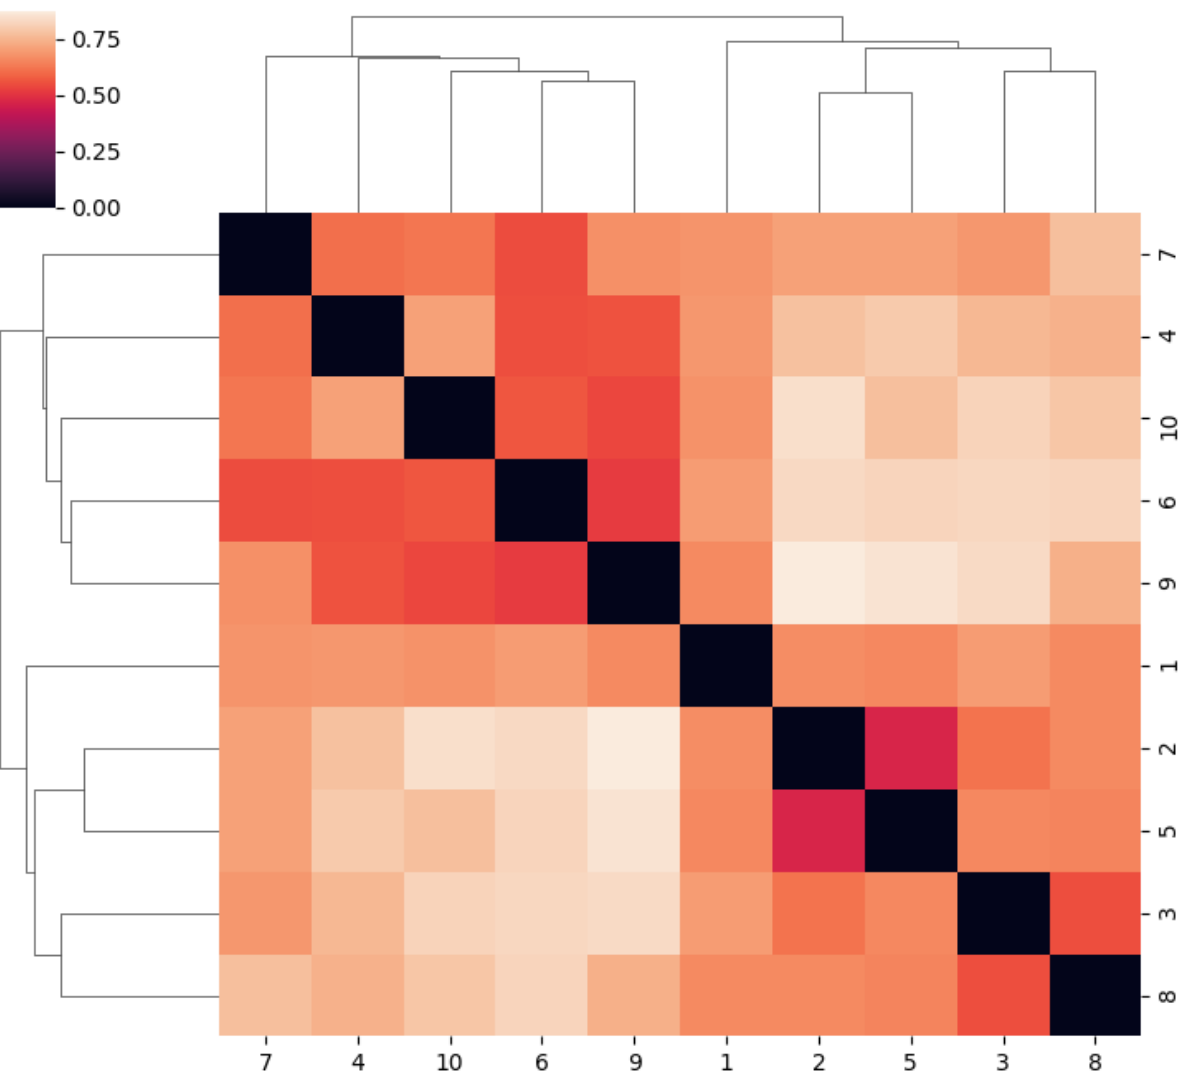
Figure 6. Heatmap of the unweighted UniFrac distances between the samples, along with a dendrogram of the agglomerative hierarchical clustering with a complete linkage method. The numbers from one to 10 on the X and Y axis represent the patient samples. The color in the figure represents phylogenetic relatedness, darker colors equals closer relatedness.